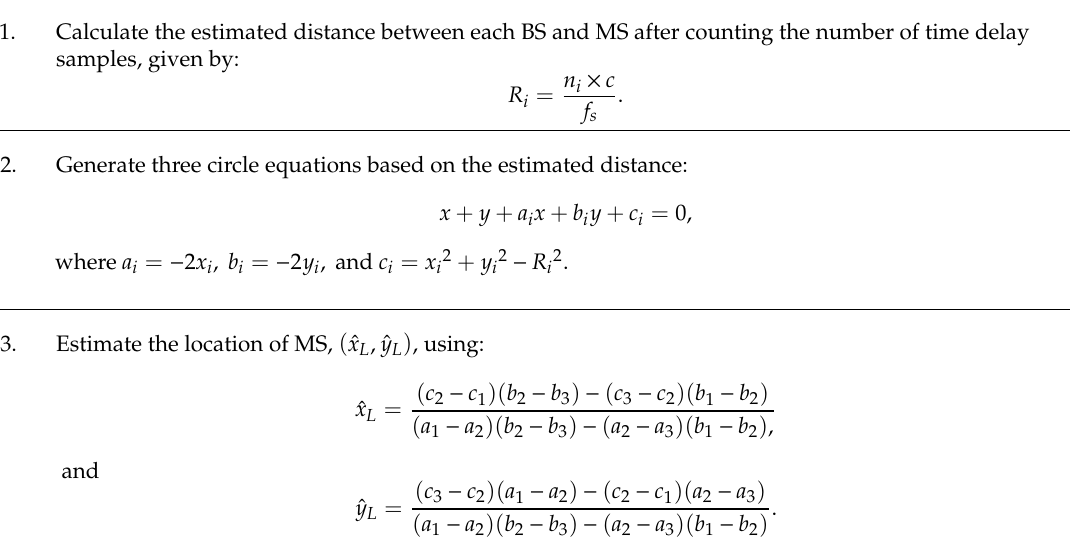
Figure 2. The concept of the line intersection algorithm. Table 1. Line Intersection Algorithm .